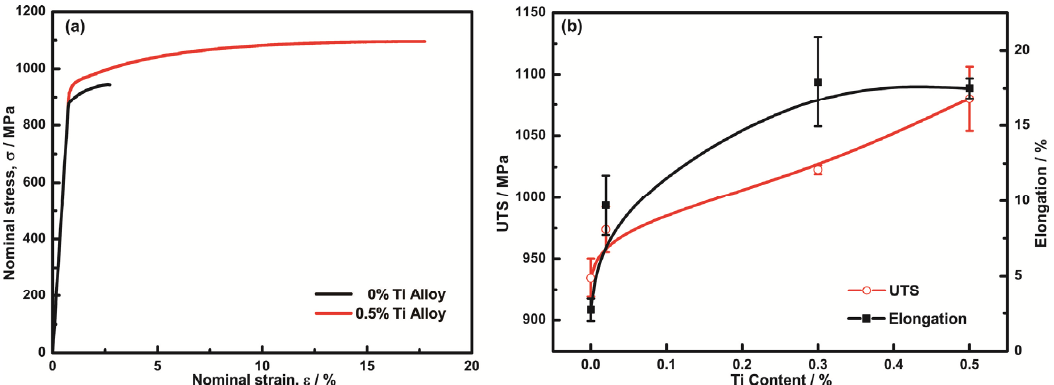
Figure 8. Mechanical properties of alloys with different contents of Ti: ( a ) Nominal stress–strain curves of 0% Ti and 0.5% Ti alloys; ( b ) Ultimate tensile strength (UTS) and tensile elongation of four alloys after aging at 400°Cfor 4h.